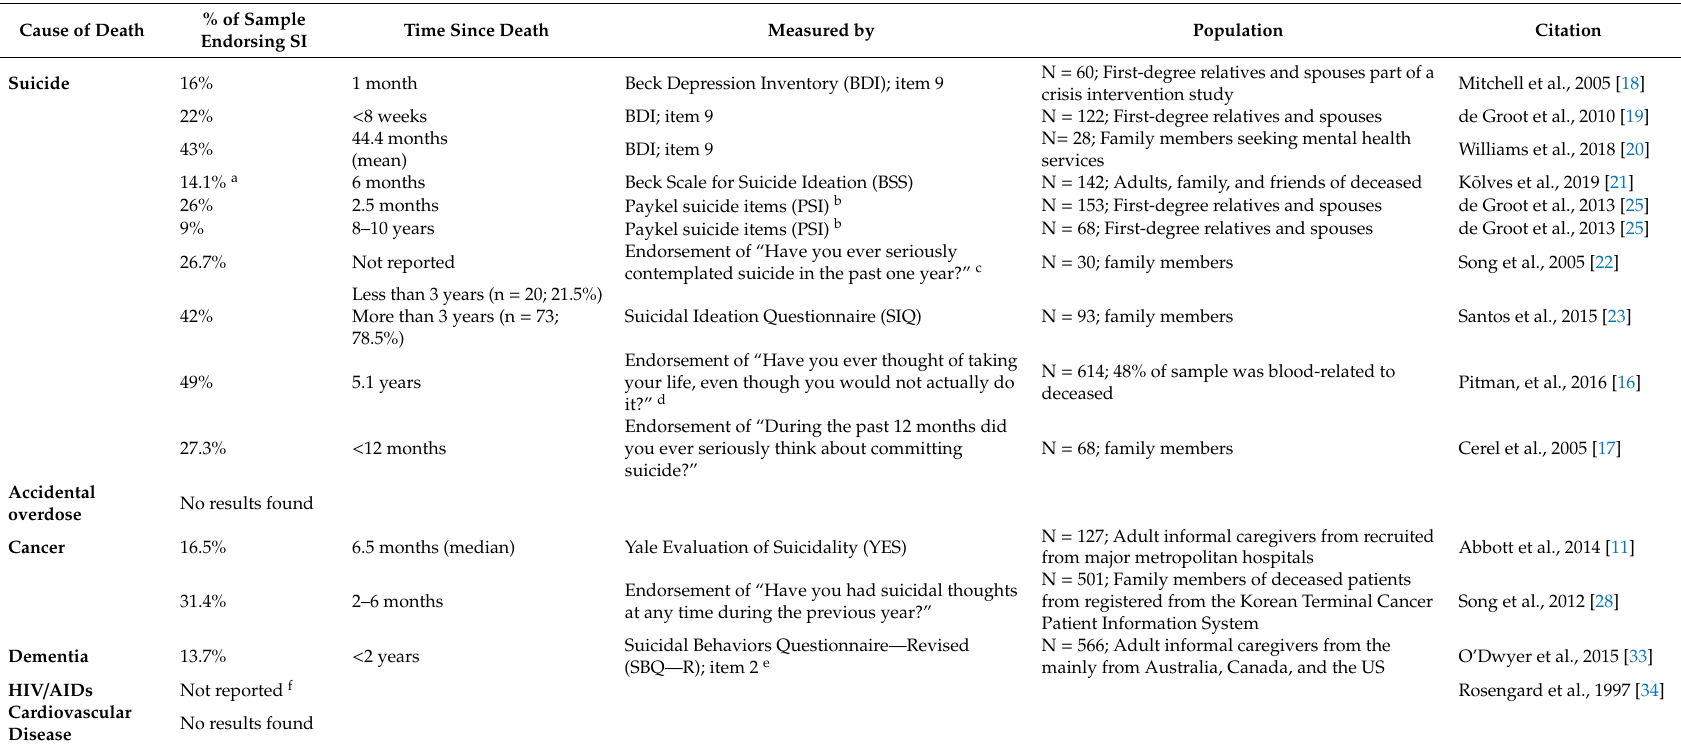
Table 2. Cause of death and percent of sample reporting suicidal ideation (SI) in